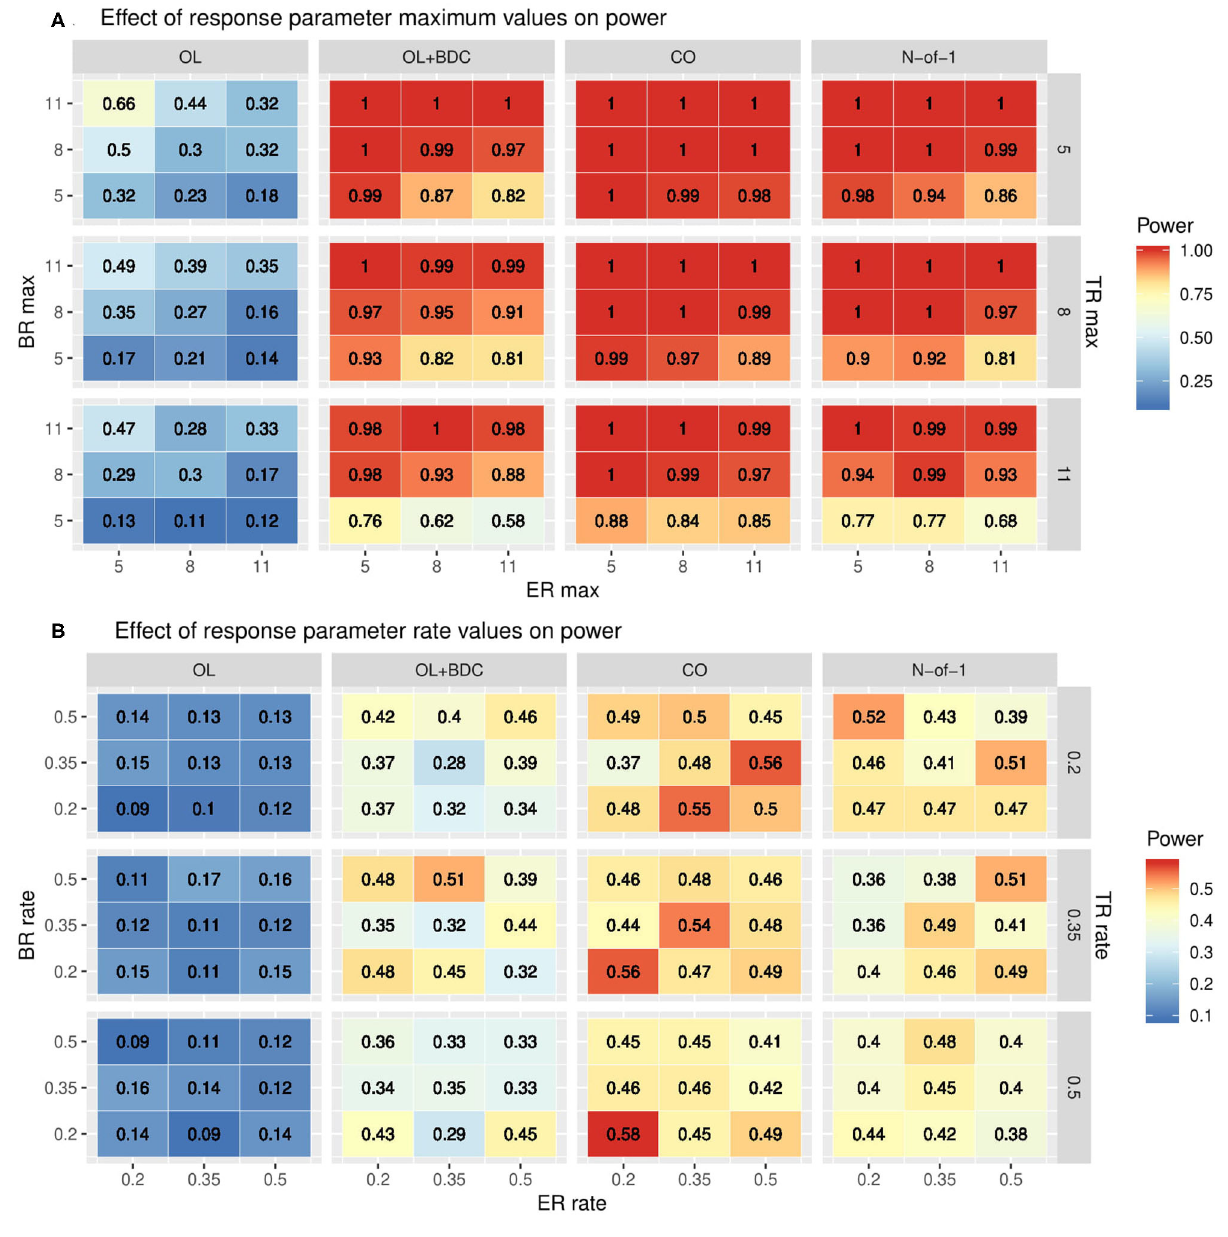
FIGURE 5 | Heat maps showing statistical power as a function of trial design and the parameters used to define (A) the maximum response or (B) the rate of change in the modified gompertz function defining the trajectories of each of the three response factors (BR = biologic response to drug, ER = expectancy-related response to drug, and TR = time-varying component unrelated to drug). In panel both panels, N is set to 35 and carryover is set to zero. In (A) the correlation between biomarker and the BR factor is set to 0.6, while in (B) it is set to 0.3. OL = open label, OL + BDC = open label followed by blinded discontinuation, CO = cross over, N-of-1 = proposed N-of-1 trial